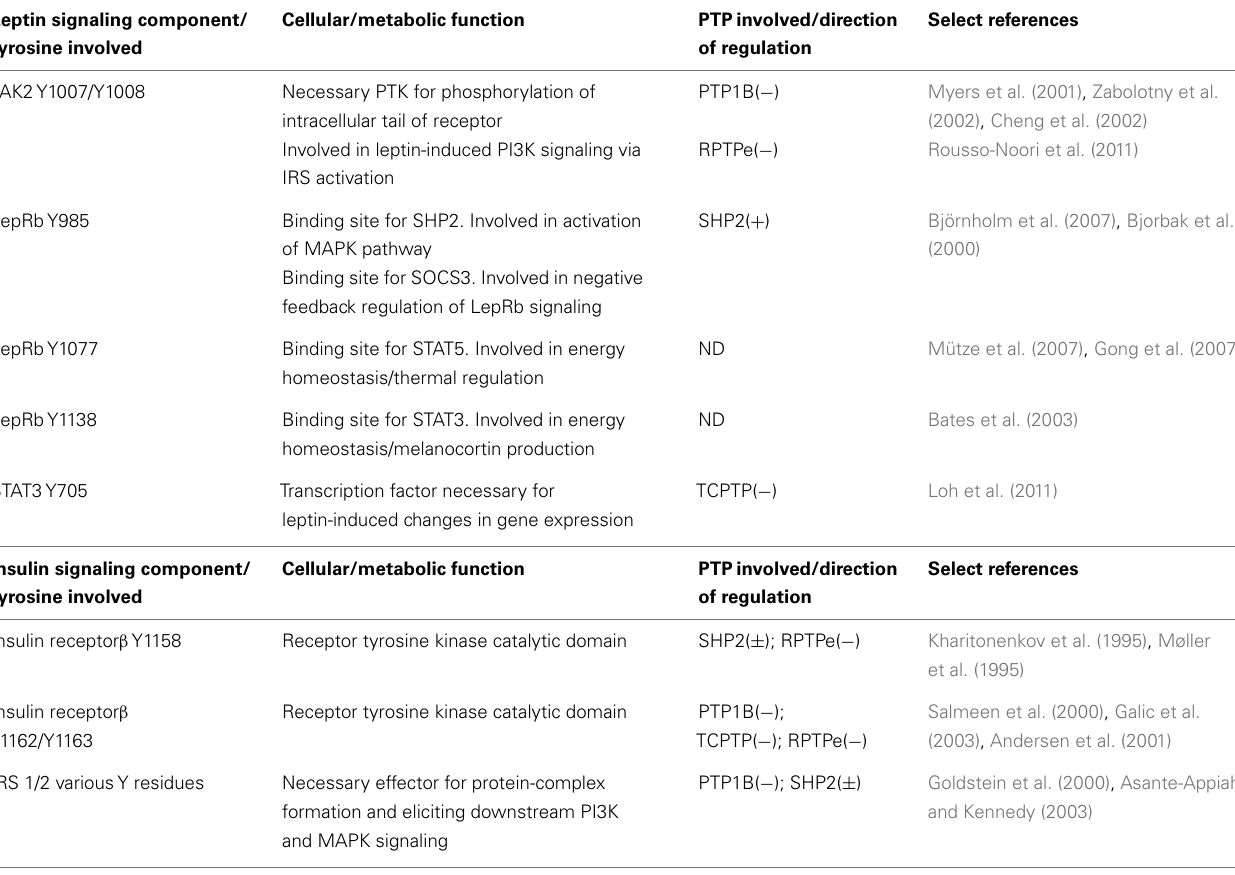
Table 1 | Summary of key tyrosine residues of leptin/insulin signaling components and their cellular/metabolic functions. Leptin signaling